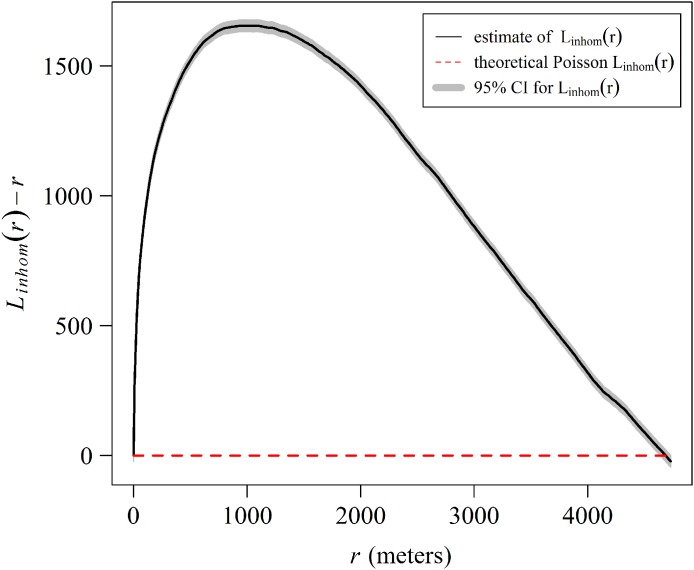
Estimate of the centered inhomogeneous L-function (solid line) for the distribution patterns of Acropora palmata colonies in Jardines de la Reina National Park, Cuba.